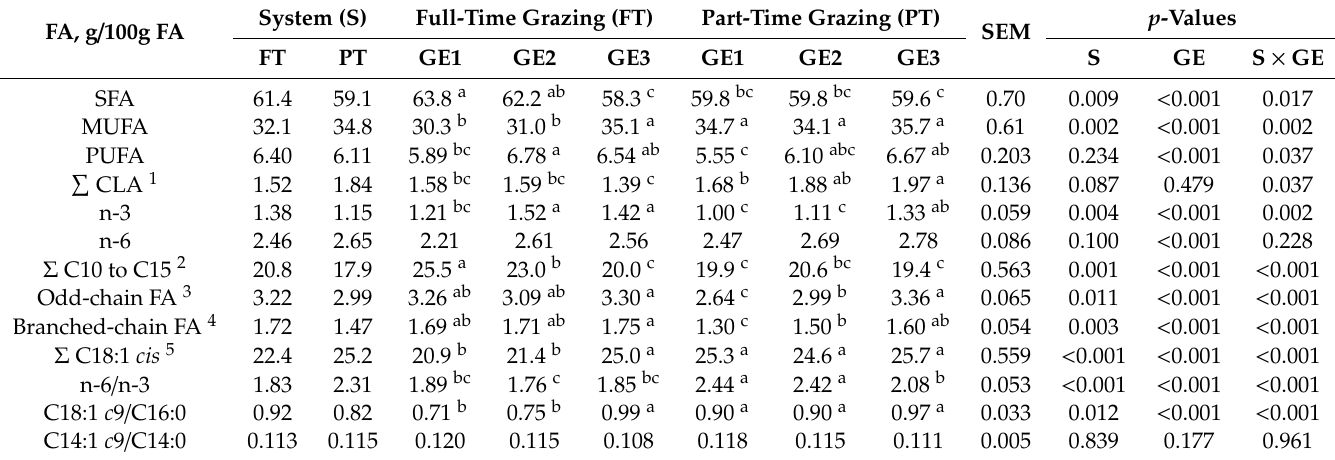
Table 6. Least square means of proportions of sums and ratios of milk FA in the two pasture management systems and the three